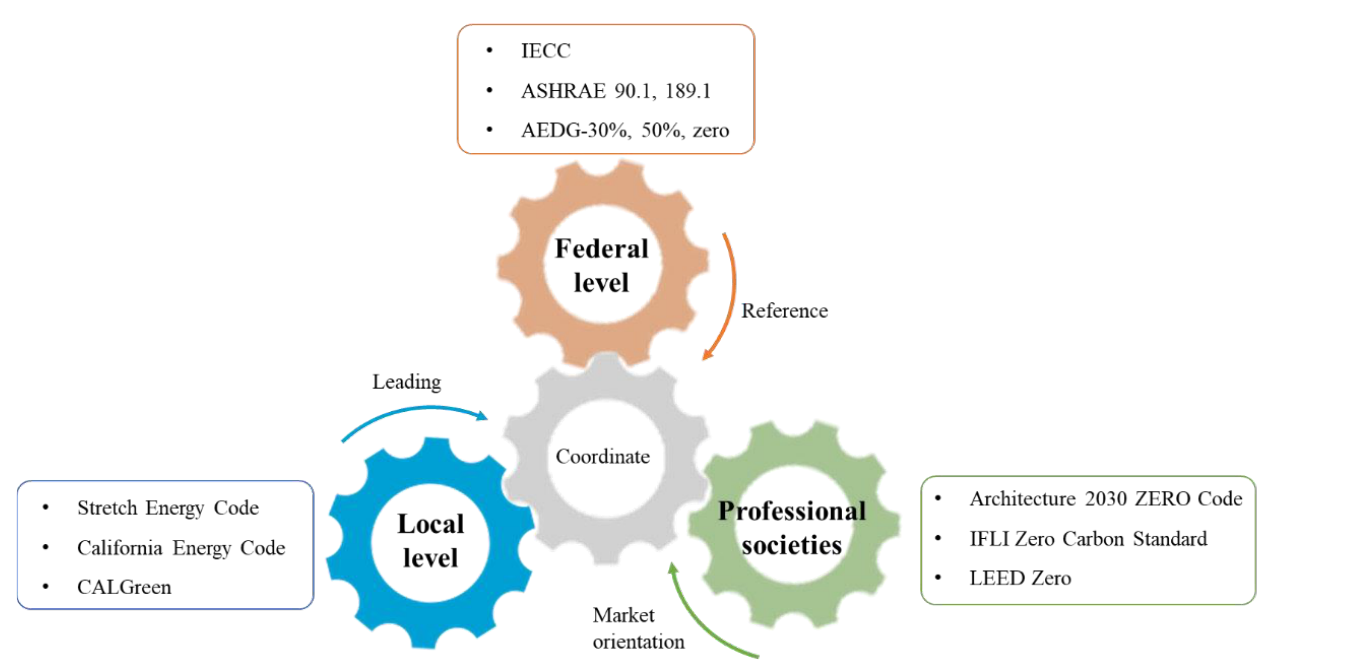
Figure 7. Relationship between ZCB-related codes and standards in the United States.